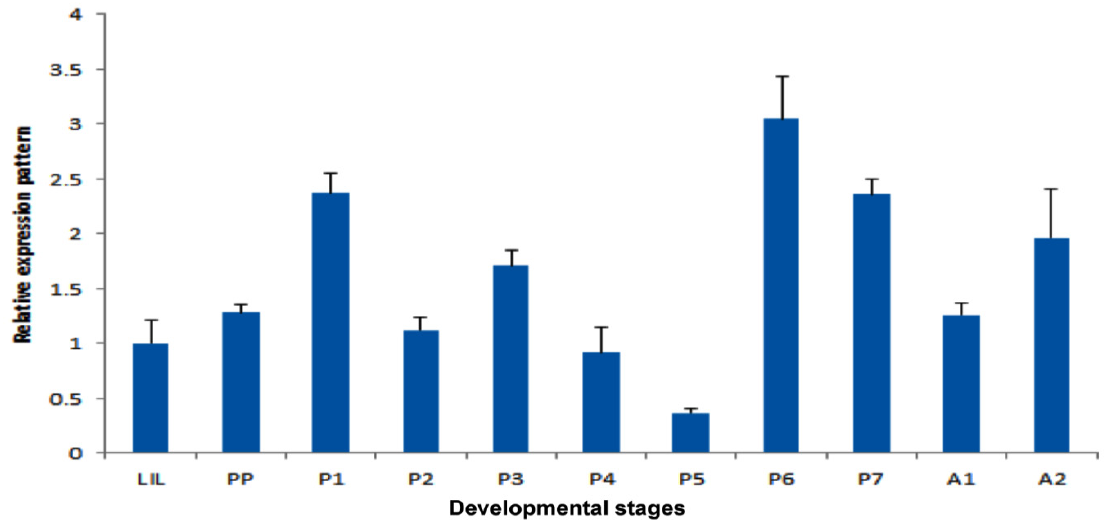
Figure 4. Temporal expression patterns of TmPGRP-LE . TmPGRP-LE transcripts at various developmental stages were quantified by real time PCR. Expression levels of the target gene were normalized to the expression of T. molitor ribosomal protein L27a ( TmL27a ) gene as an internal control and compared to that of the last instar larva. Statistical bars indicate mean ± SEM for three independent